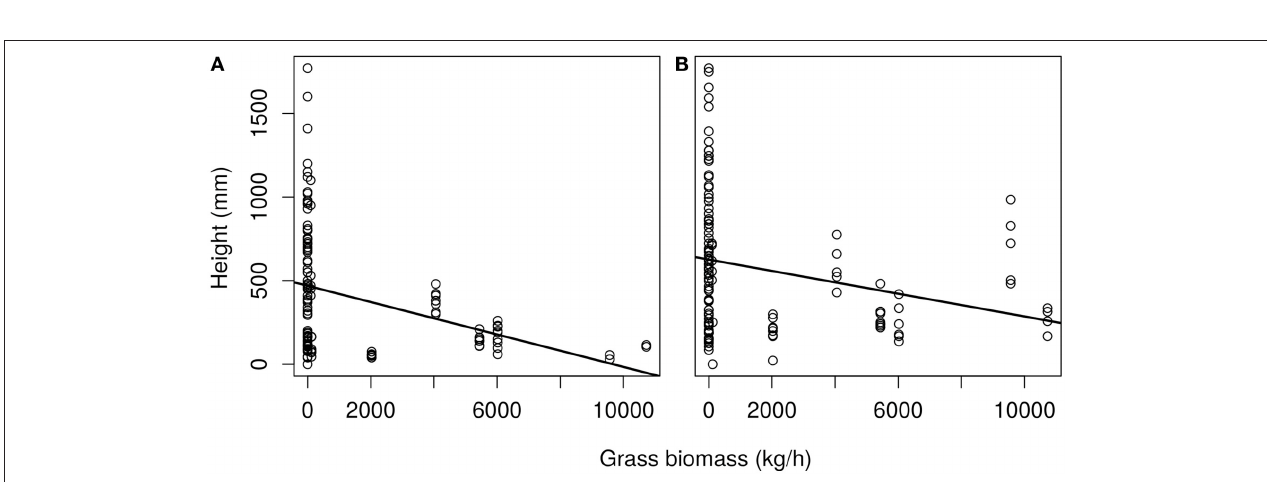
FIGURE 5 | Plant height against time since planting for S. nigrescens saplings grown with grass (black triangle) and without grass (gray filled circle). Paired sites are arranged (L–R) in order of increasing latitude, with higher elevation sites in the top panel and lower elevation sites in the bottom panel. The dashed lines demonstrate the 5th and 95th quantiles for grassy plots (gray) and non-grass plots (black). Shaded graphs indicate a site which is within the distribution range.